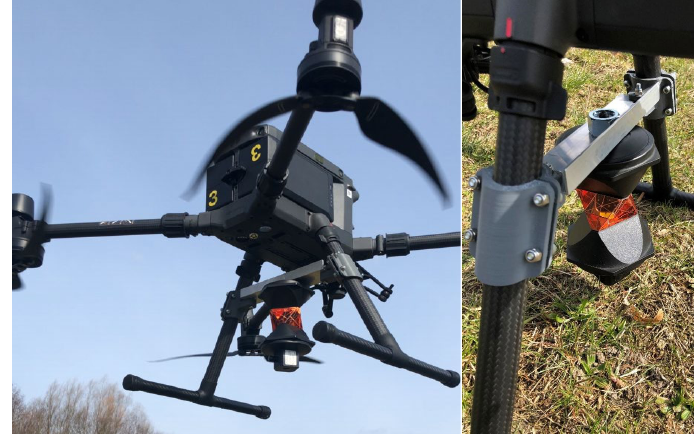
Figure 2. DJI MATRICE 300 RTK with Leica GRZ122 360 ◦ prism reflector. Geodetic coordinates in the reference frame were determined with the static GNSS method during two measurement sessions lasting 45 min each with 4 TOPCON Hiper SR